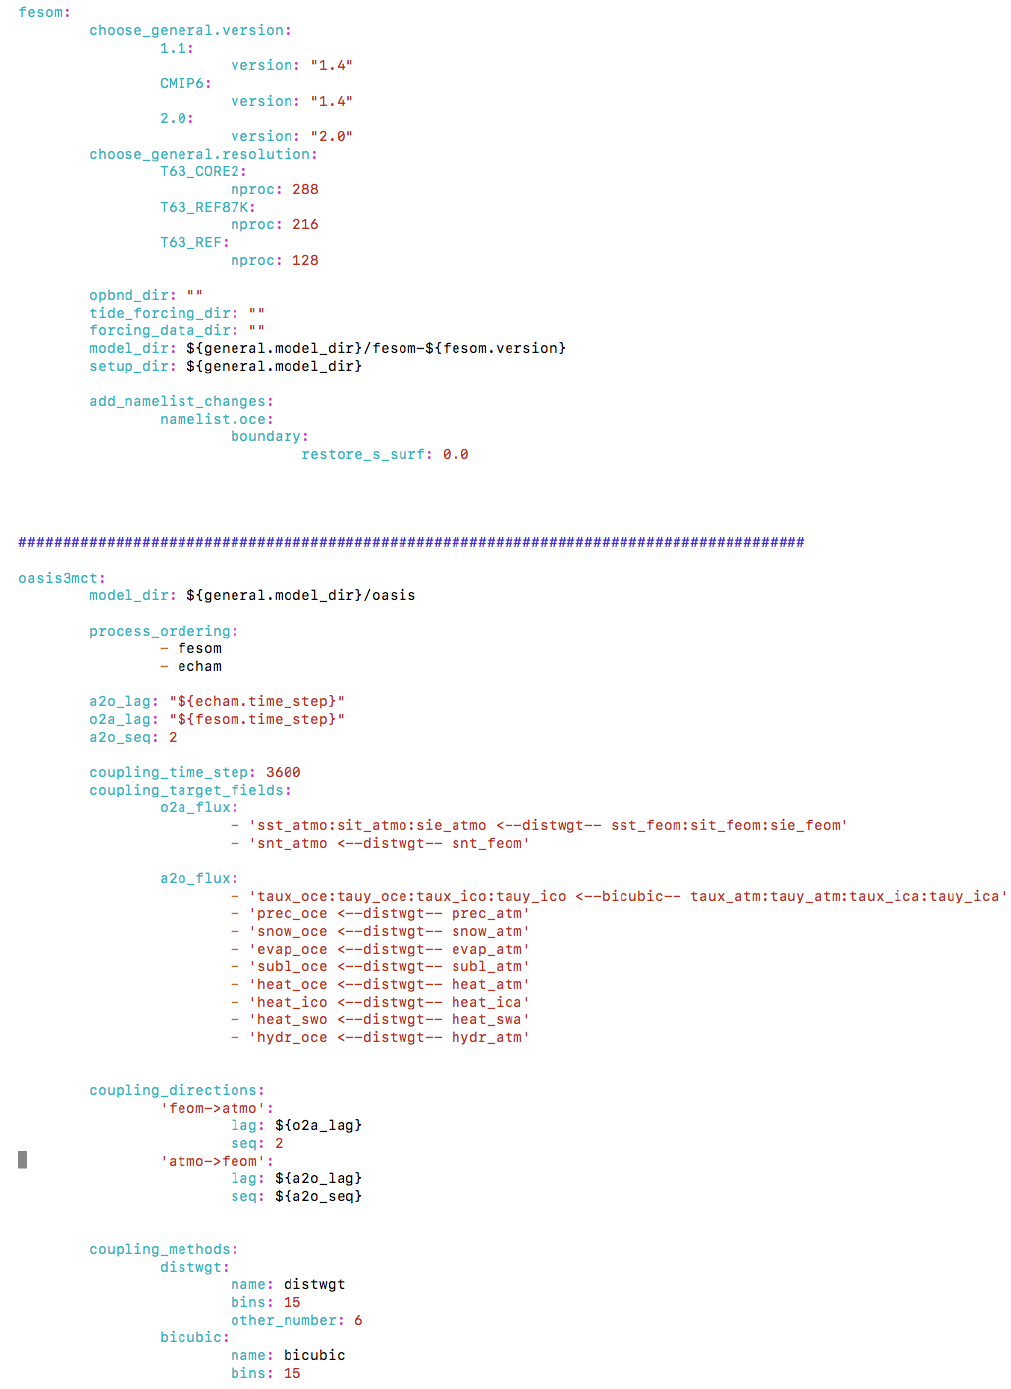
Figure A3. Example of YAML configuration file, coupled model setup AWICM-2.0, part 2 of 2.